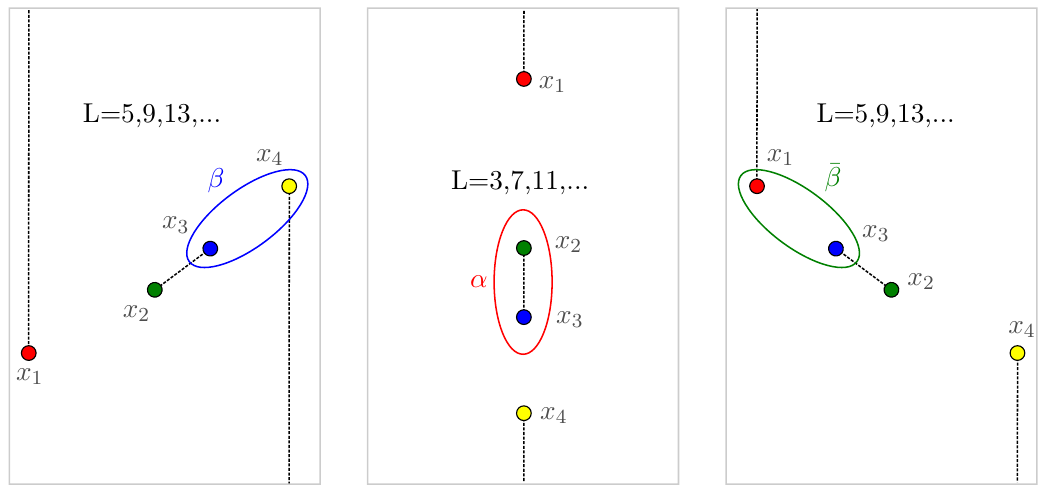
Figure 13 . Integration contours entering the Bohr-Sommerfeld quantization condition for di(cid:11)erent states. For L = 3+4 n the integral is taken around the branch points which collide at large d (middle panel). For L = 5 + 4 n , for half of the states, the integration goes around the branch points which collide at d = 3 e 2 (cid:25)i= 3 (left panel) and for another (complex conjugated) half of states the integration goes around the branch points which collide at d = 3 e (cid:0) 2 (cid:25)i= 3 (right